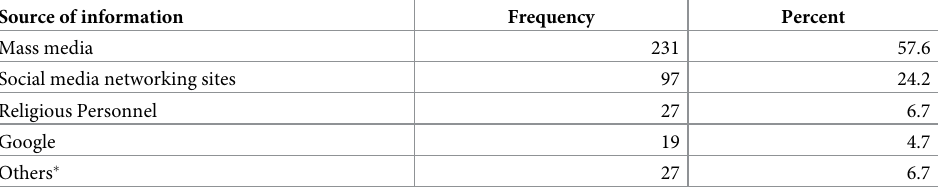
Table 4. The primary source of information about COVID-19 vaccines.